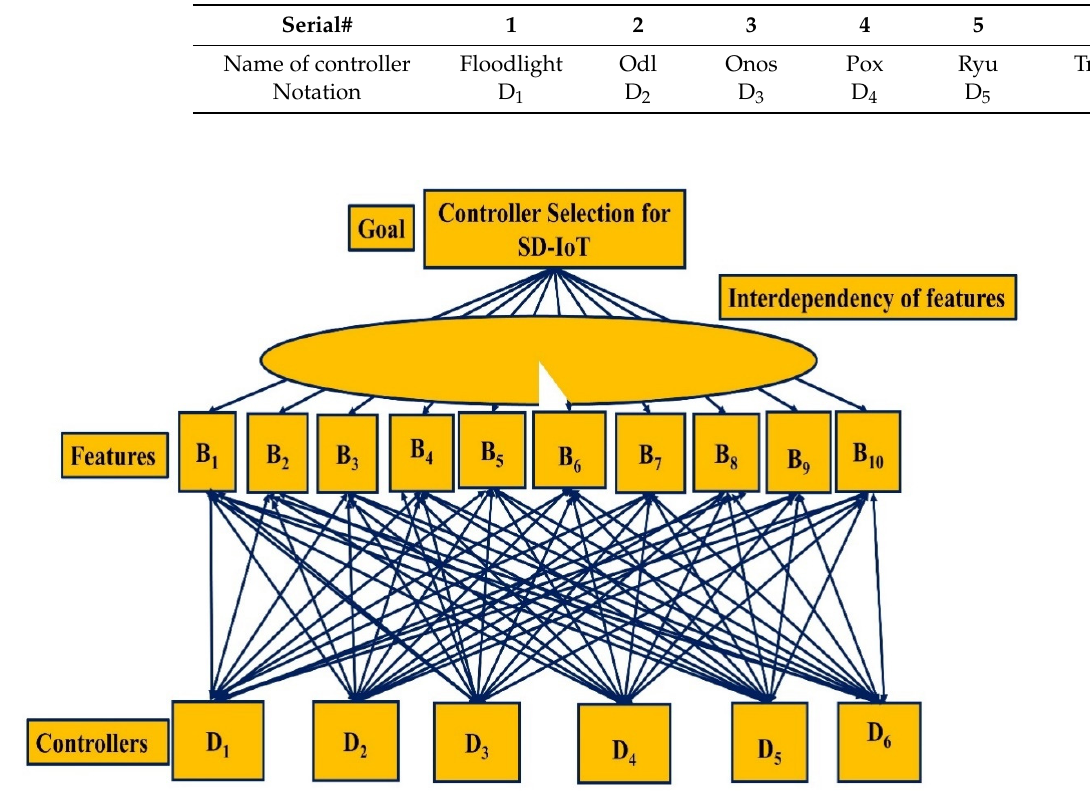
Table 2. List of controllers for comparison and notations.